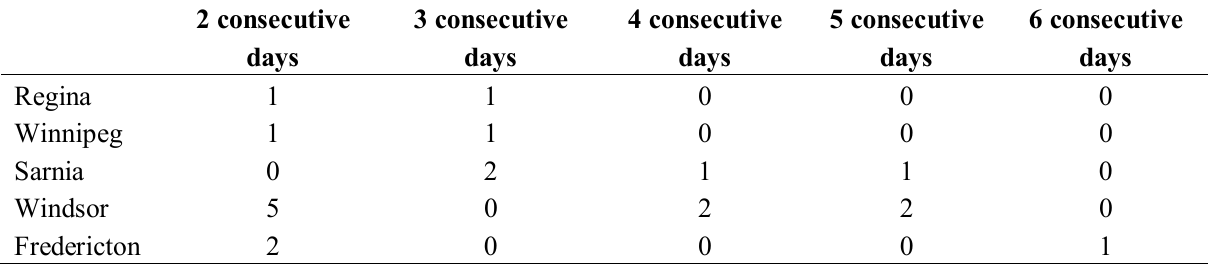
Table 4. Number of episodes with 2 or more consecutive days with maximum temperature above 30 °C between 1 May and 10 September 2010 by